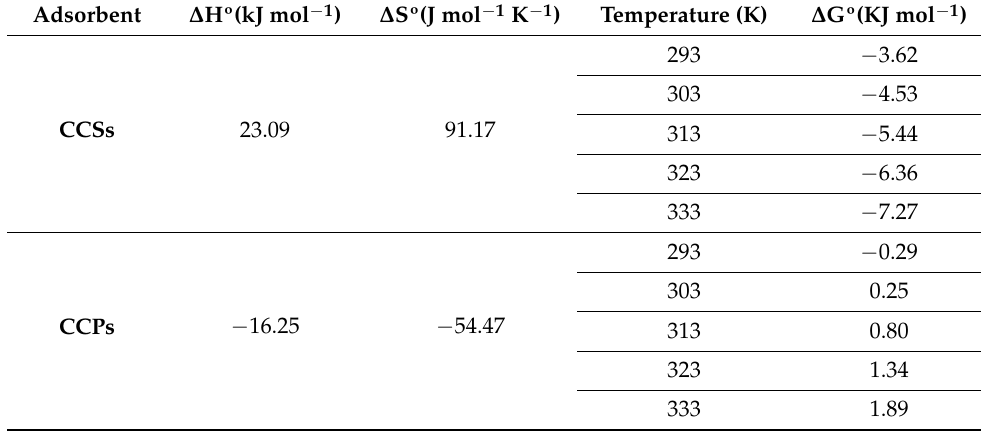
Table 7. Thermodynamic parameters for MB dye adsorption by CCSs and